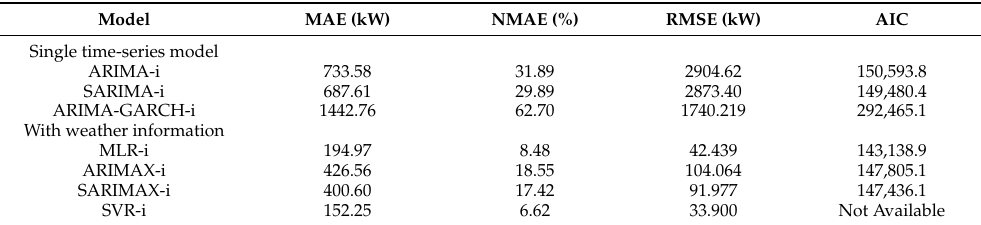
Table A1. Comparison of performance of each model including artificial control